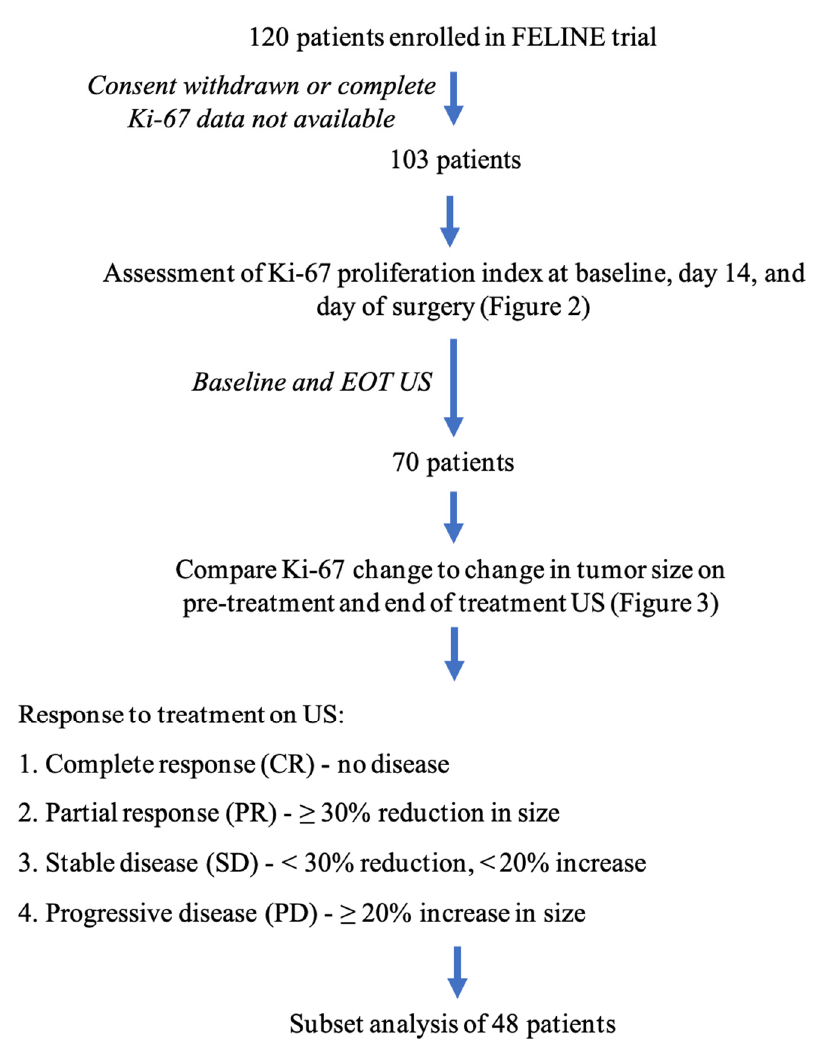
Figure 1. Graphical depiction of study methods. EOT = End of treatment; US =